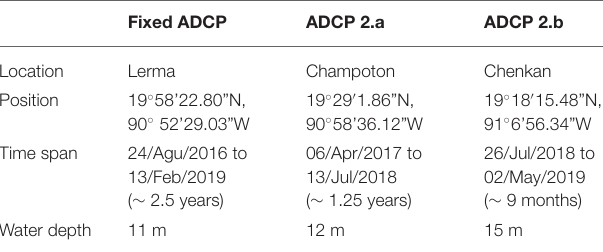
Fixed ADCP ADCP 2.a ADCP 2.b Location Lerma